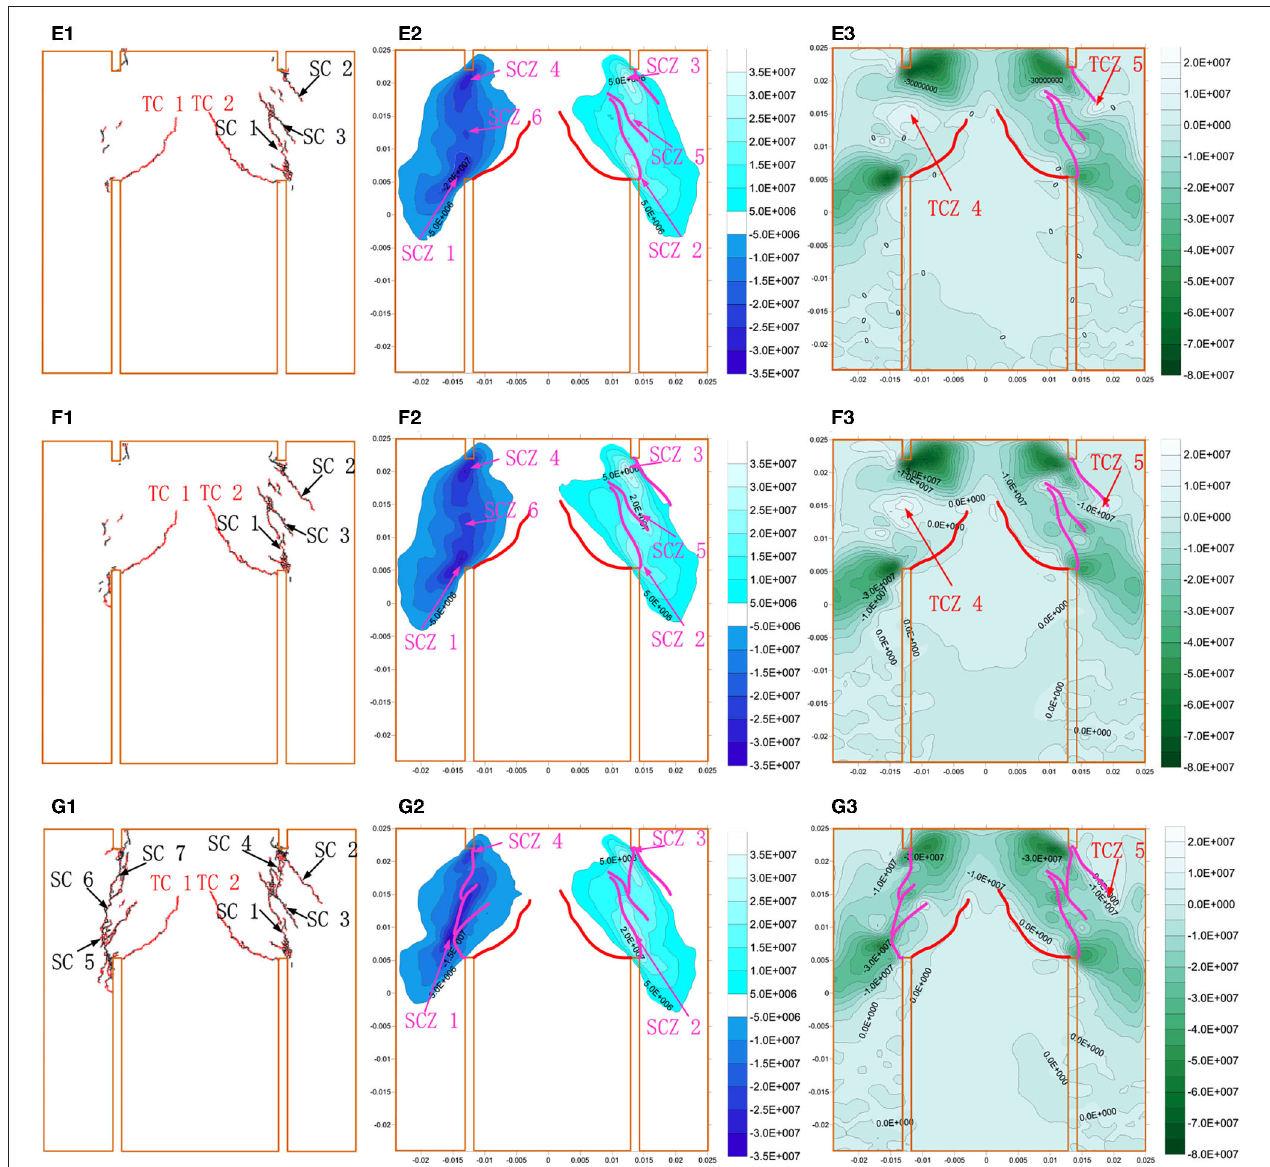
FIGURE 6 | Fracture development and stress distributions in the shear process: (A1–G1) are the fracture developments, (A2–G2) are the shear stress distributions, and (A3–G3) are the maximum principal stress distributions at the typical monitor points (A–G) .